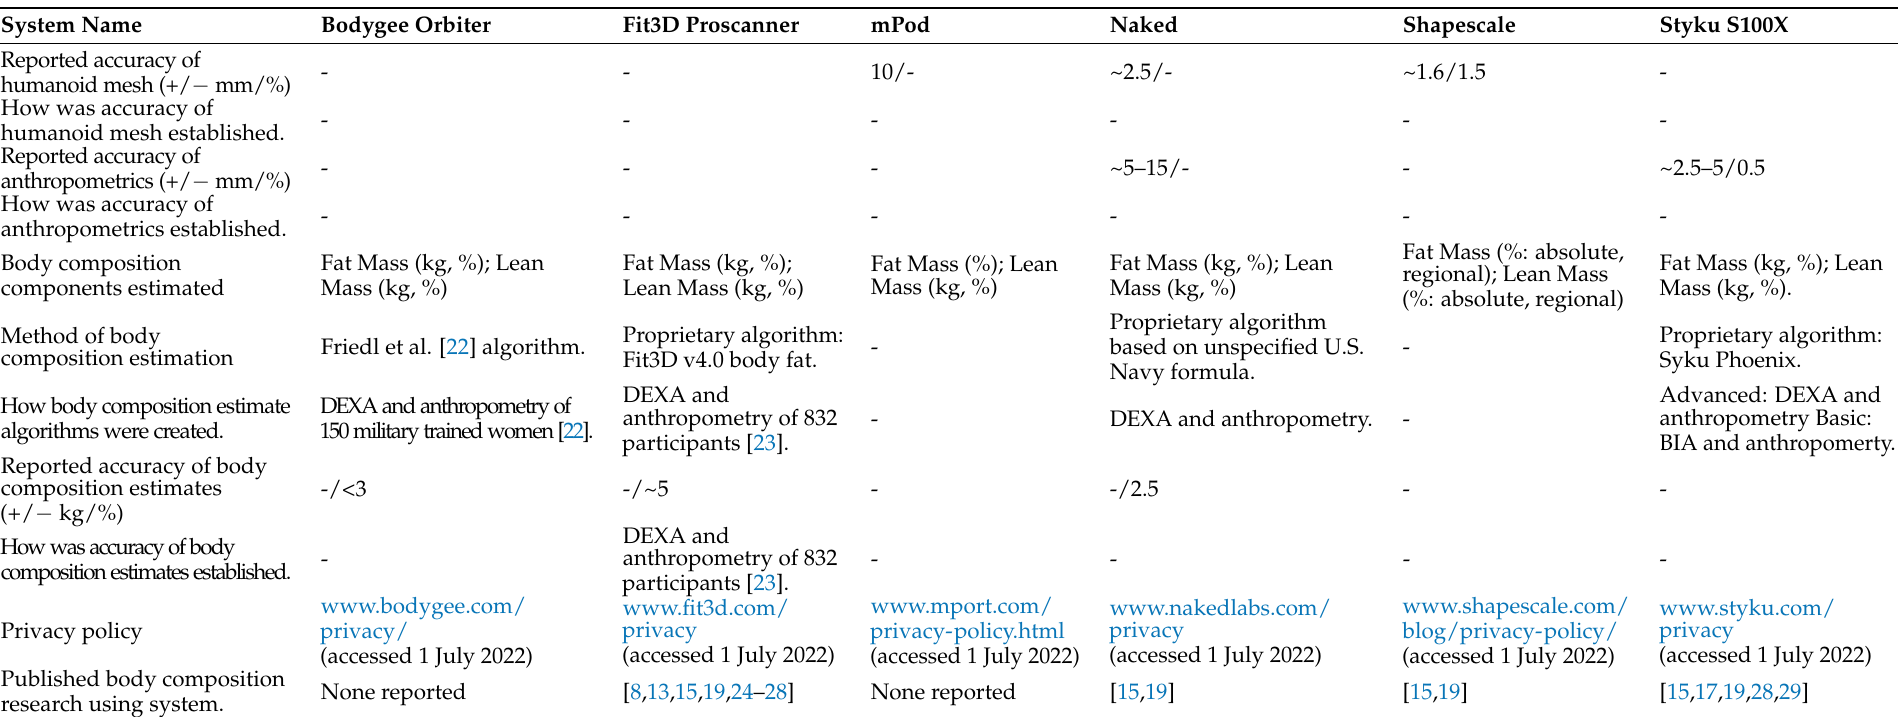
Table 2. The reported accuracy of the humanoid mesh, anthropometrics and body composition estimates for each 3D surface imaging system, in which “-“ represents not